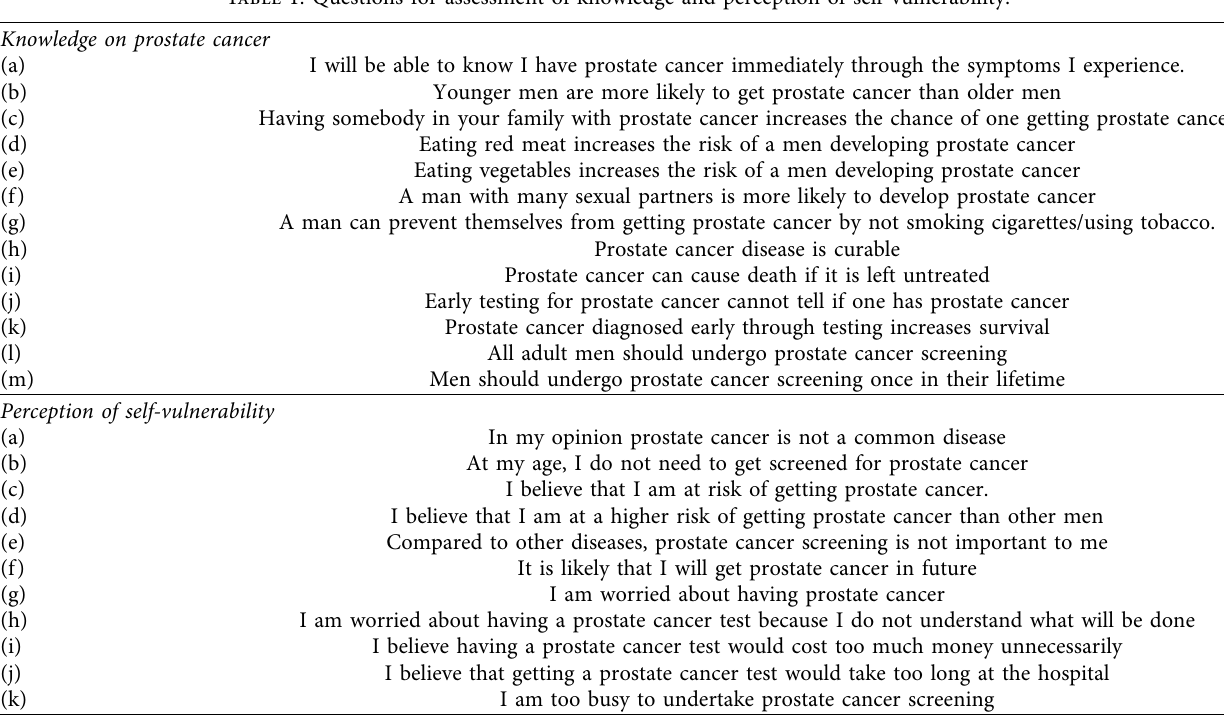
Table 1: Questions for assessment of knowledge and perception of